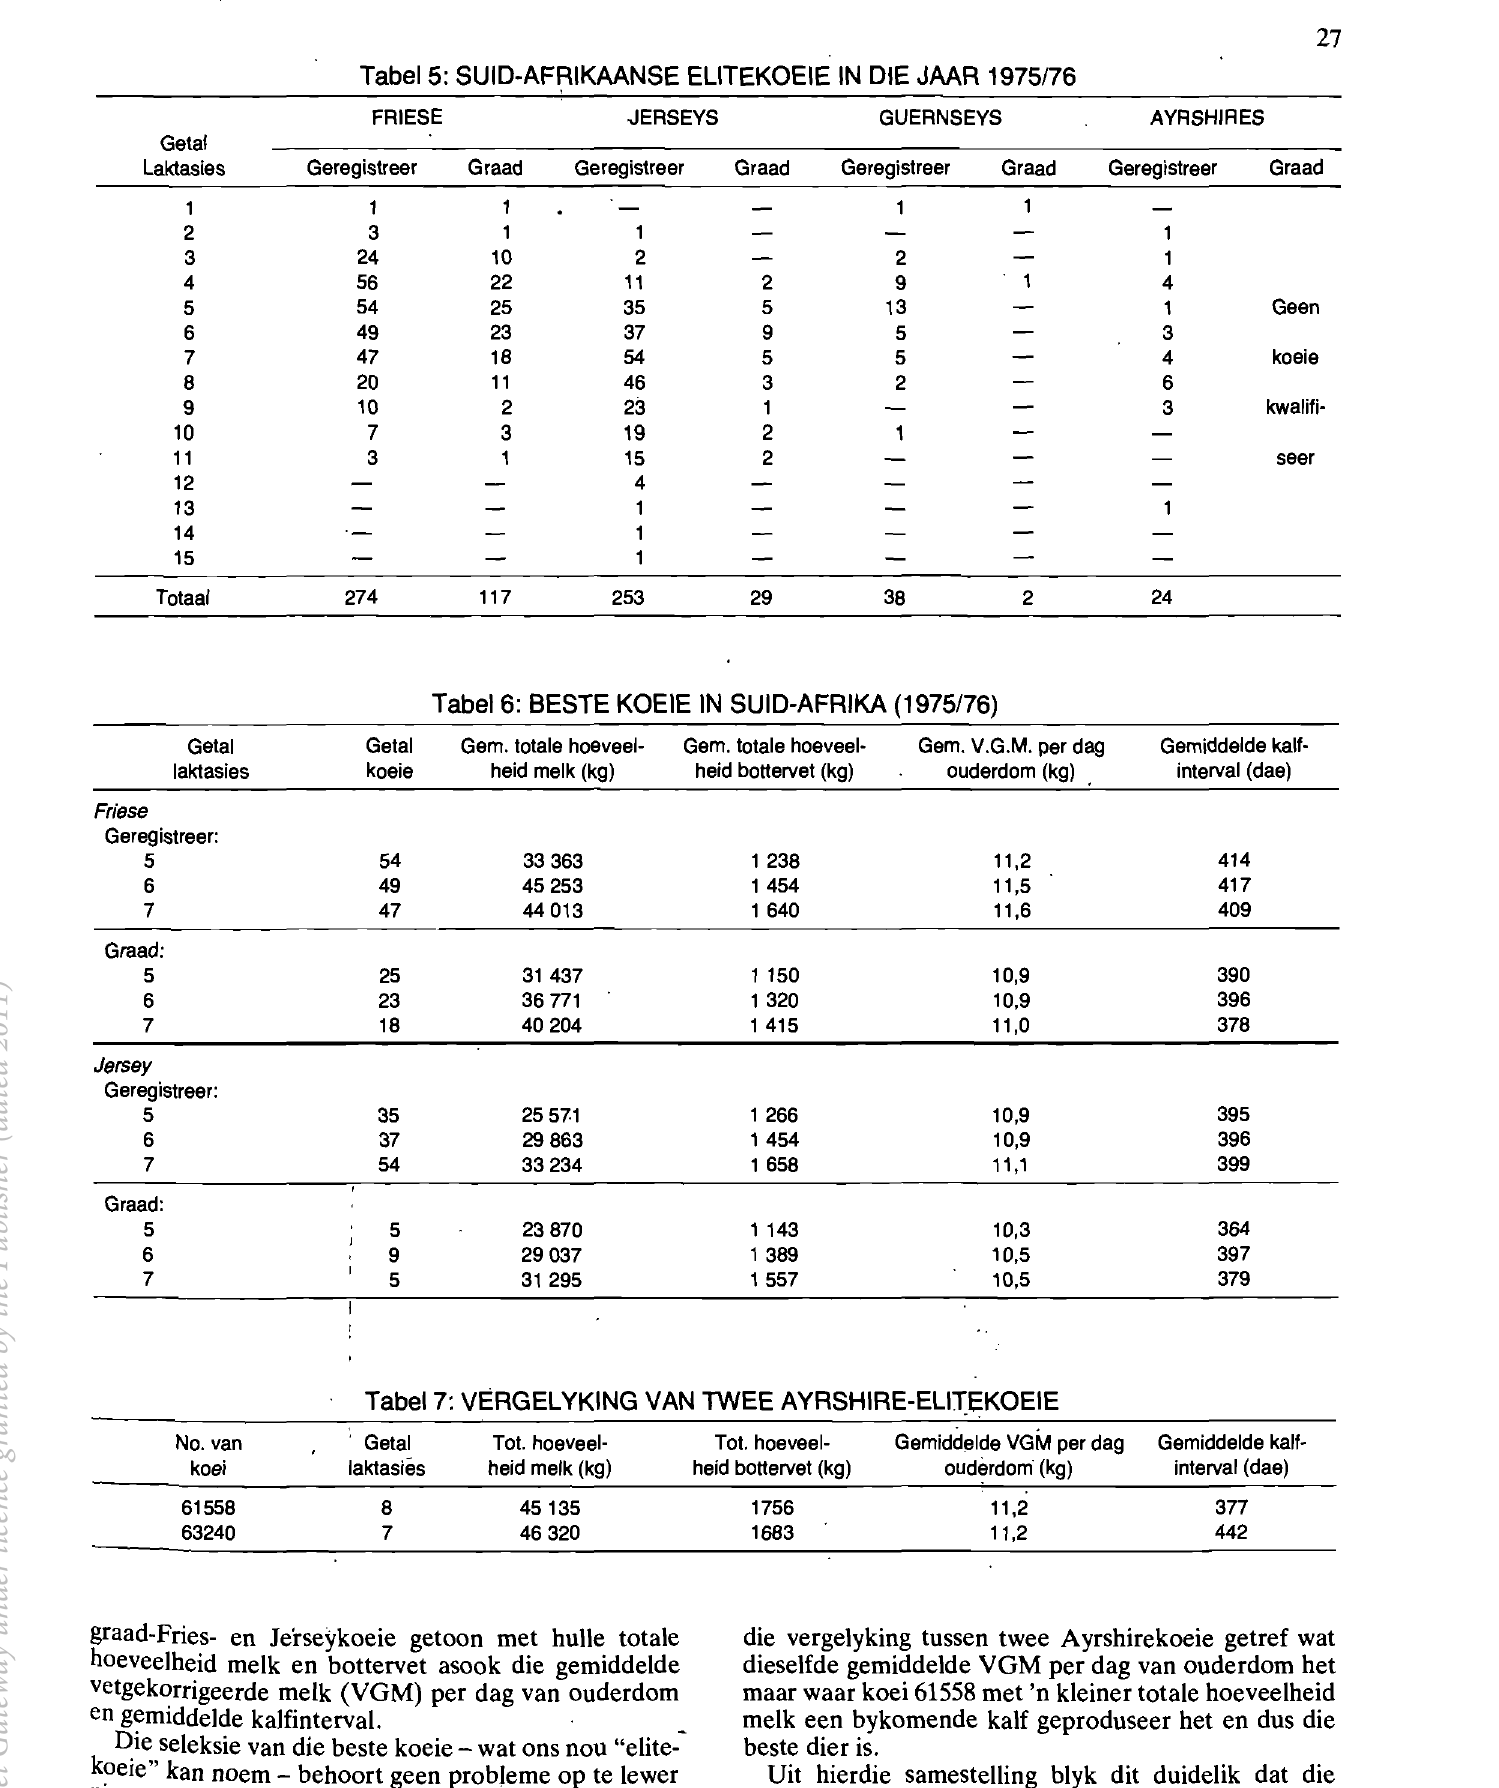
geprodus~er, die gemiddelde VGM per dag van ouder dom en dIe gemiddelde kalfinterval. In TabeI 7